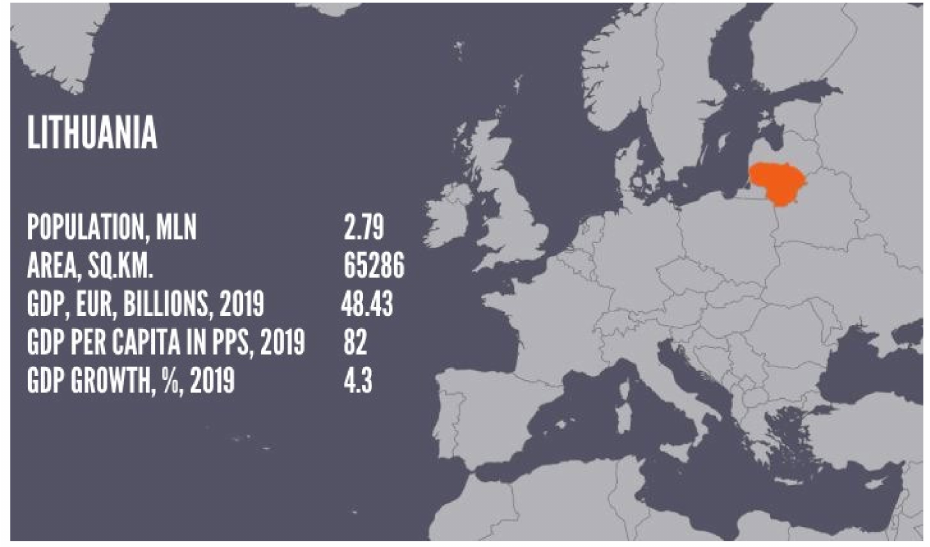
Figure 18. Stylized facts about Lithuania (designed by the authors, based on